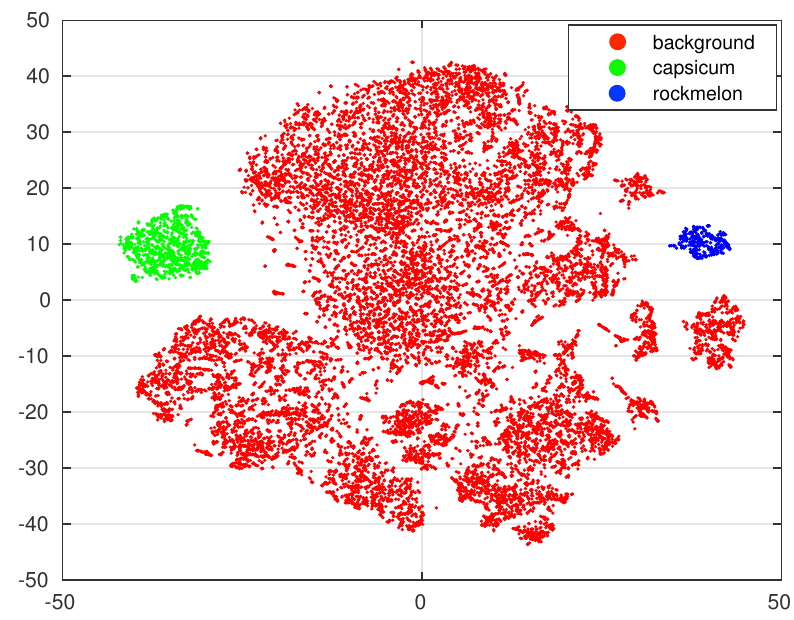
Figure 5. t-SNE feature visualisation of 3 classes. The 4k dimensions of features are extracted from the Fc7 layer and visualised in 2D. For the visualisation, 86 images are randomly selected from the dataset and processed for the network shown in Figure